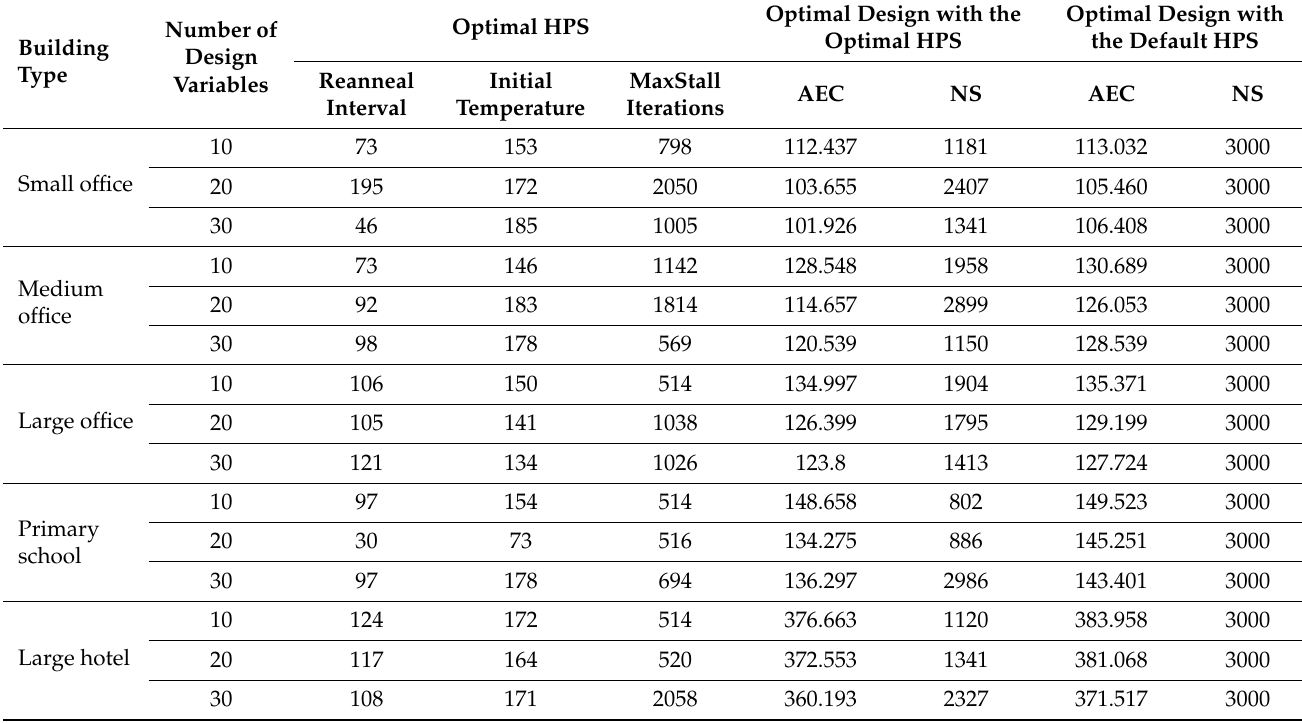
Table 7. Optimal HPSs for the SA.